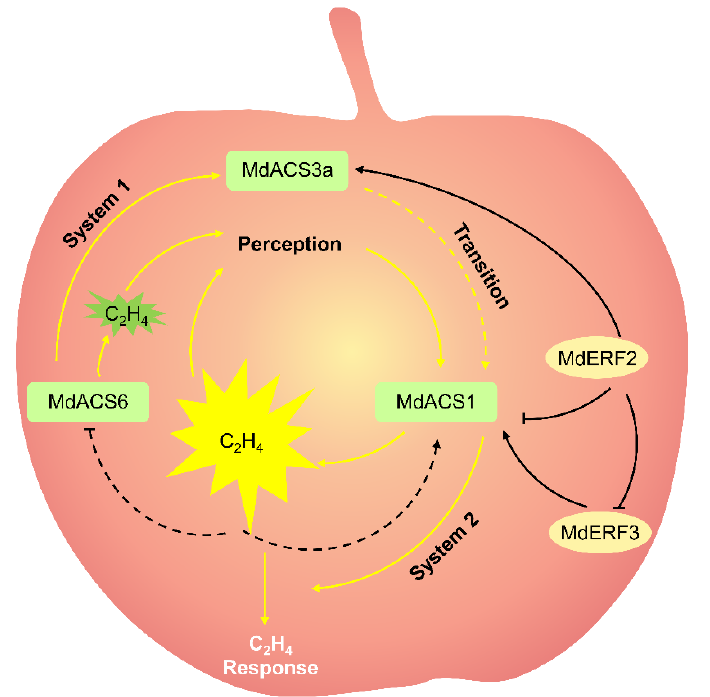
Figure 1. Systems 1 and 2 ethylene in apple fruit ripening. → , promotion; ⊥ , suppression; solid arrow, clear regulation mechanism; dotted arrow, unclear regulation mechanism; SAM, S -adenosyl methionine; ACC, 1-aminocyclopropane-1-carboxylic acid; C 2 H 4 ; ethylene.